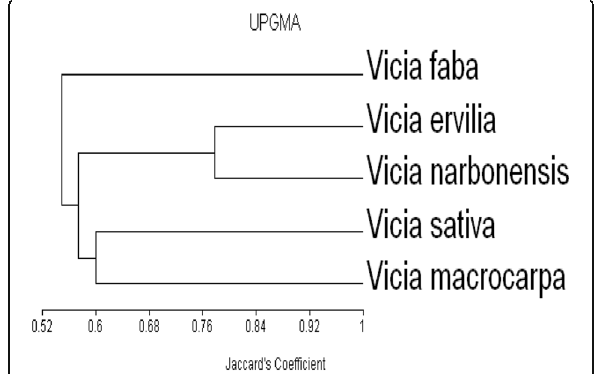
Fig. 3 UPGMA dendrogram of Vicia species based on frequencies of seed soluble proteins